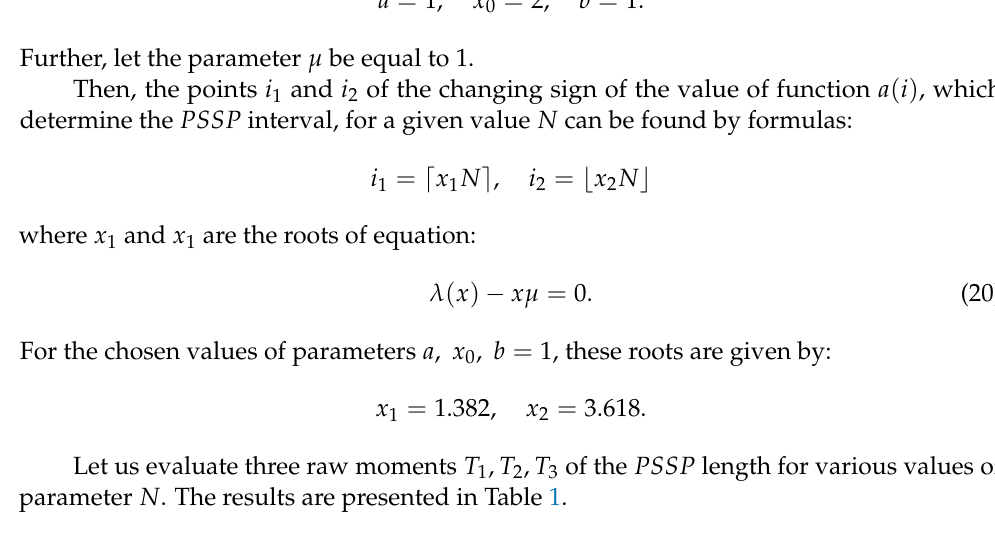
Table 1. Values of raw moments T n of the n -th order for the PSSP length ( n = 1,2,3) for various values of parameter N .